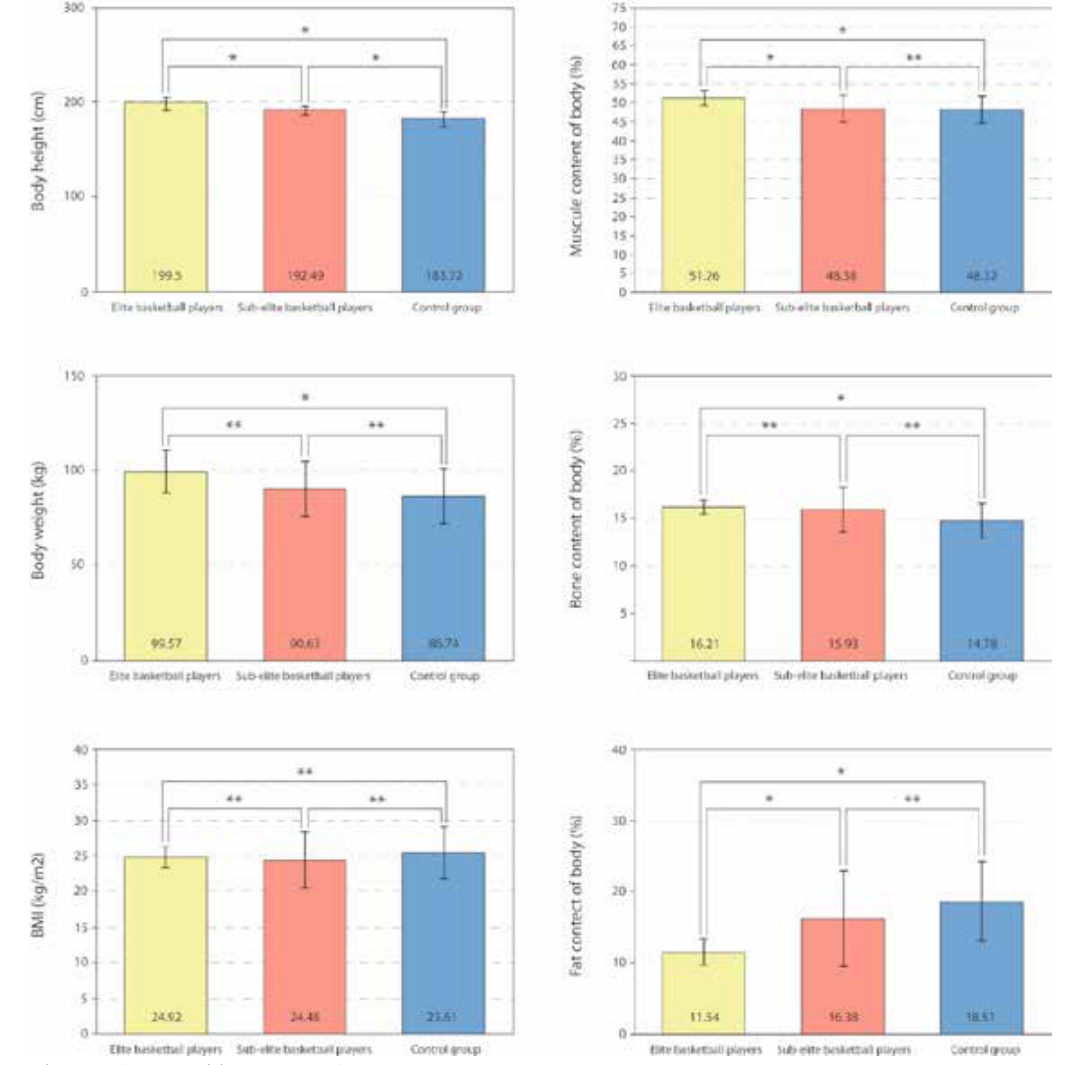
Figure 1. LSD Post Hoc test for the different parameters among the